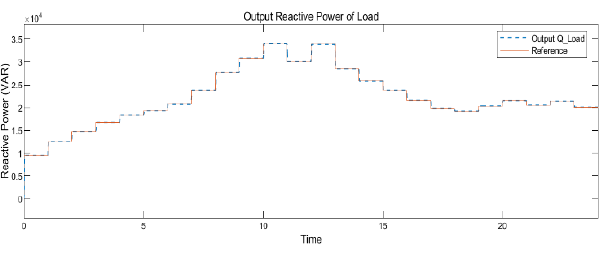
Fig. 16. Real power of load in switching condition